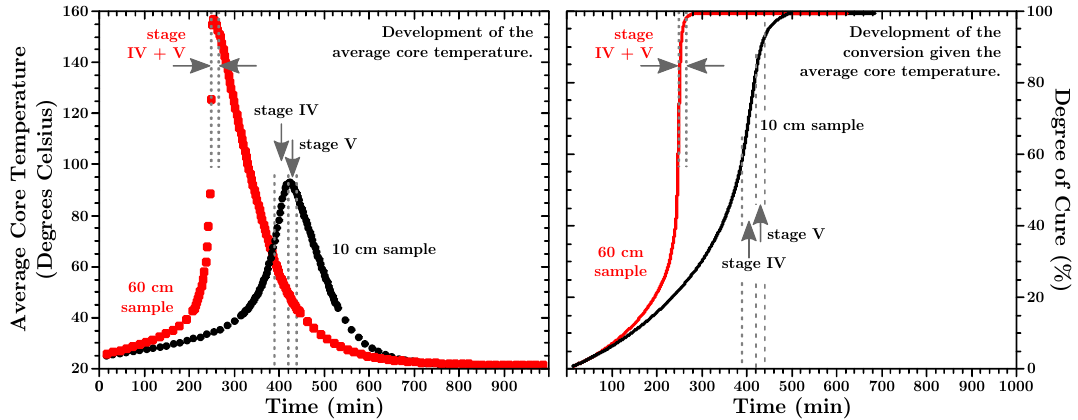
Figure 7. Development of the average core temperature (left image) and the degree of cure (right image) in the 10cm (black dots/line) and the 60cm (red squares/line)